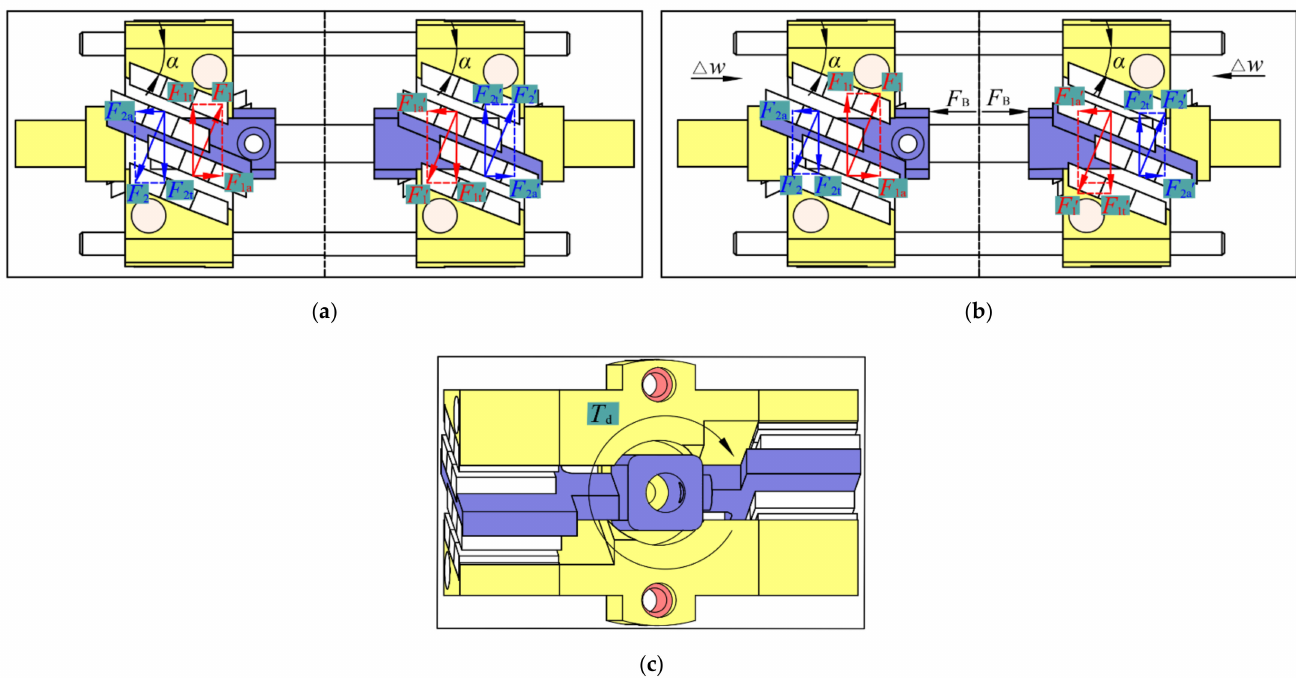
Figure 4. Force analysis of maglev coupling: ( a ) front view and rear view when not electrified; ( b ) front view and rear view when electrified; and ( c ) side view when